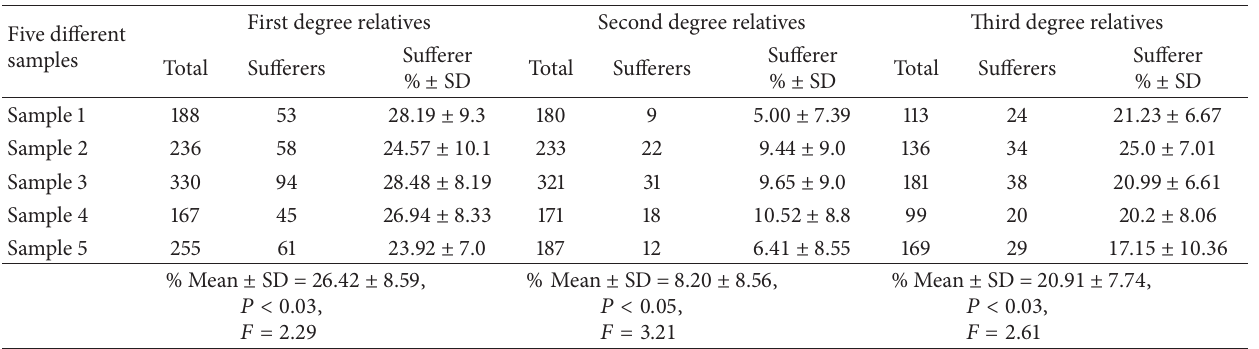
Table 2: Showing the relative frequencies of blood injection and injury phobia among the first, second, and third degree relatives of probands. Five different samples